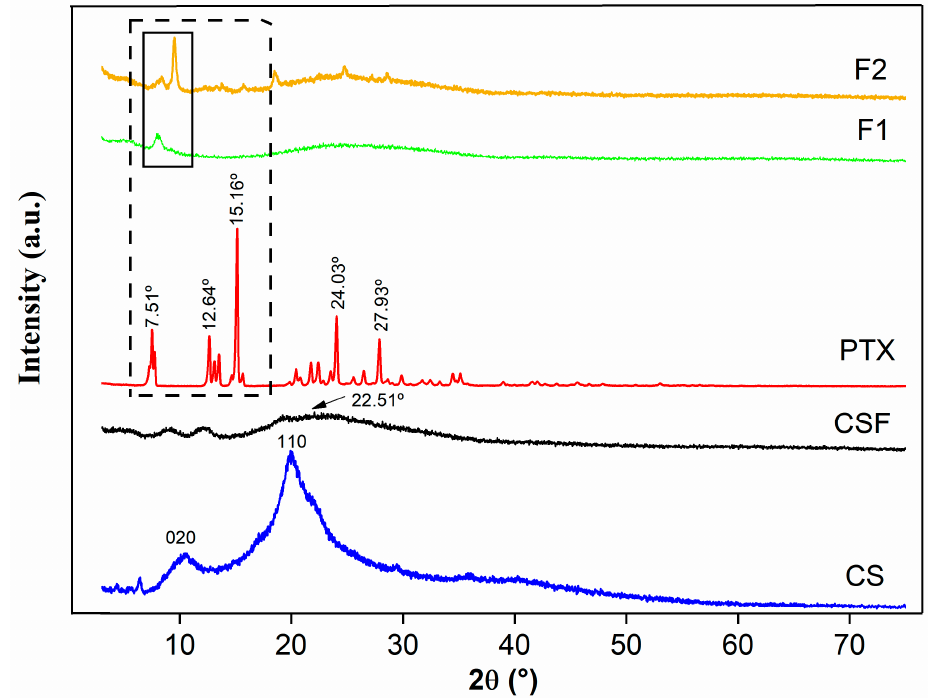
Figure 3. X-ray diffraction spectrum of CS (chitosan, blue line), CSF (chitosan films, black line), PTX (pentoxifylline, red line), F1 (2 mg/mL of pentoxifylline, green line), and F2 (4 mg/mL of pentoxifylline, golden line).